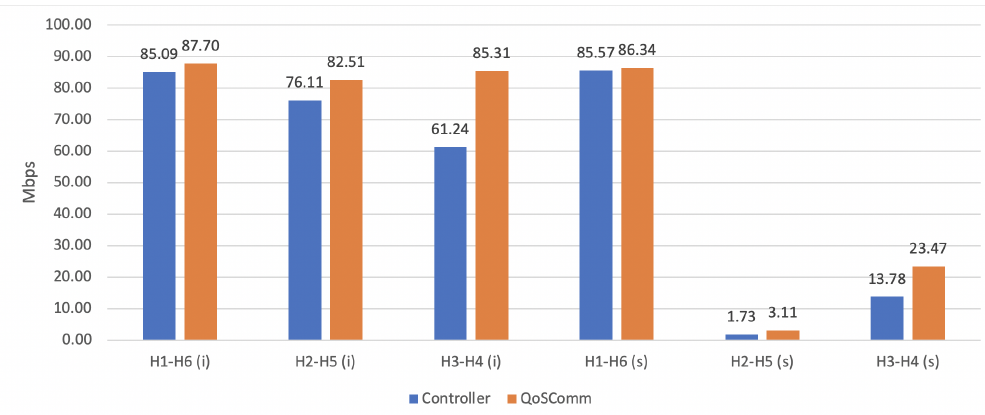
Figure 6. IPERF TCP data transfer comparison (average mbps). Tests execution: (i) individually; (s) simultaneously. Time interval: 30 s. STDEV: H1-H6i (2.03, 0.85), H2-H5i (0.67, 0.57), H3-H4i (4.29, 6.36); H1-H6s (1.23, 0.54), H2-H5s (0.41, 0.87), H3-H4s (3.20, 3.64).